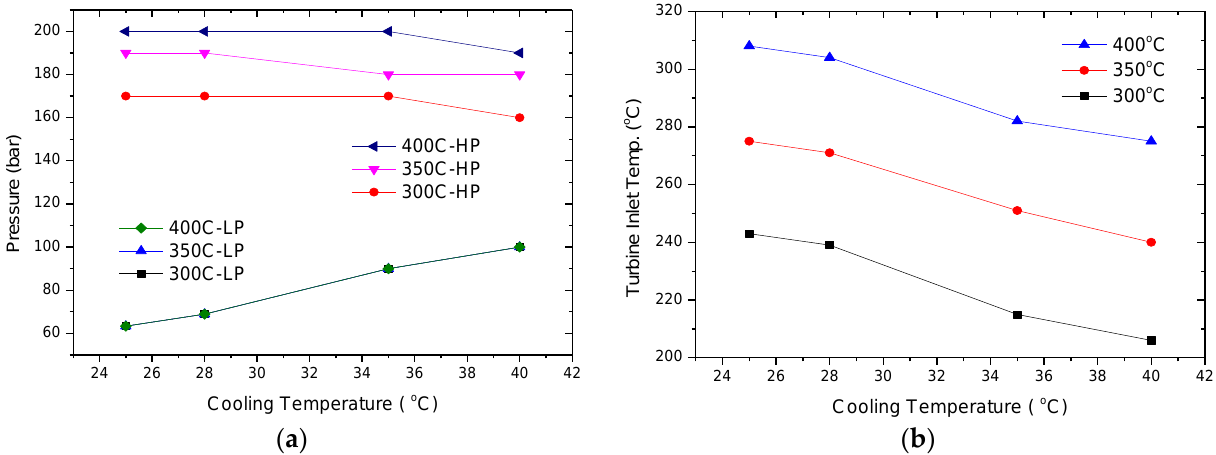
Figure 8. Optimal operating condition of S-CO 2 power cycle for given exhaust gas temperature from engine: ( a ) Low- pressure (LP) and high-pressure (HP) sides; ( b ) turbine inlet temperature.